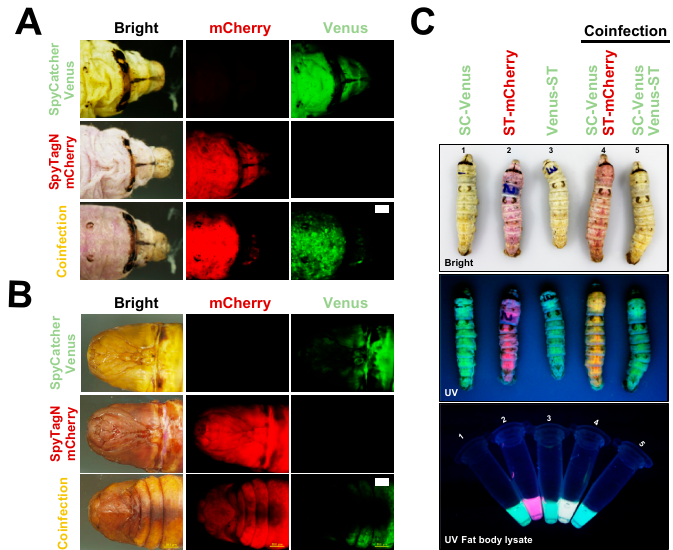
Figure 2. Production of ST- and SC-tagged proteins in silkworm-BEVS. Recombinant bacmid (s) from ST / SC constructs, SC-Venus and ST-N-mCherry were pre-mixed with DMRIE-C transfection reagents and then injected into the third day of silkworm 5th instar larvae ( A ) and silkworm pupae ( B ). The fluorescent signals of EGFP, Venus or mCherry were verified under ultraviolet light (UV). Meanwhile, the whole silkworm larvae and lysates of fat body tissue at 5 d post-infection (dpi) of recombinant baculoviruses were also investigated for fluorescent signals ( C : upper panel, larvae body under bright light; middle panel, larvae body under UV light; fat body lysates under UV light). All the corresponding expressions could be verified based on the colors of the epidermis or the crude lysate of fat body tissue.